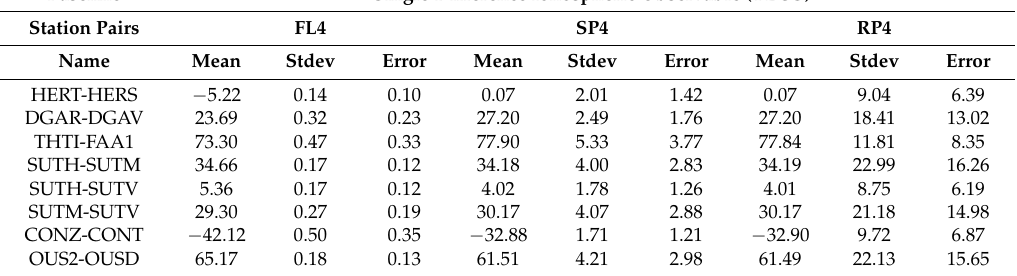
Table 5. Summary results of the mean, standard deviation and observation error of the single difference ionospheric observable between the co-located receivers for all the satellites arcs for DOY 173 to 175,